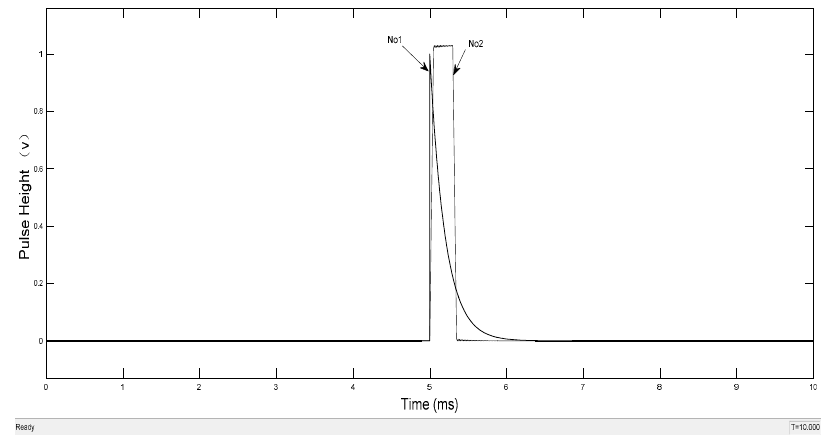
Figure 5. Trapezoidal pulse output.